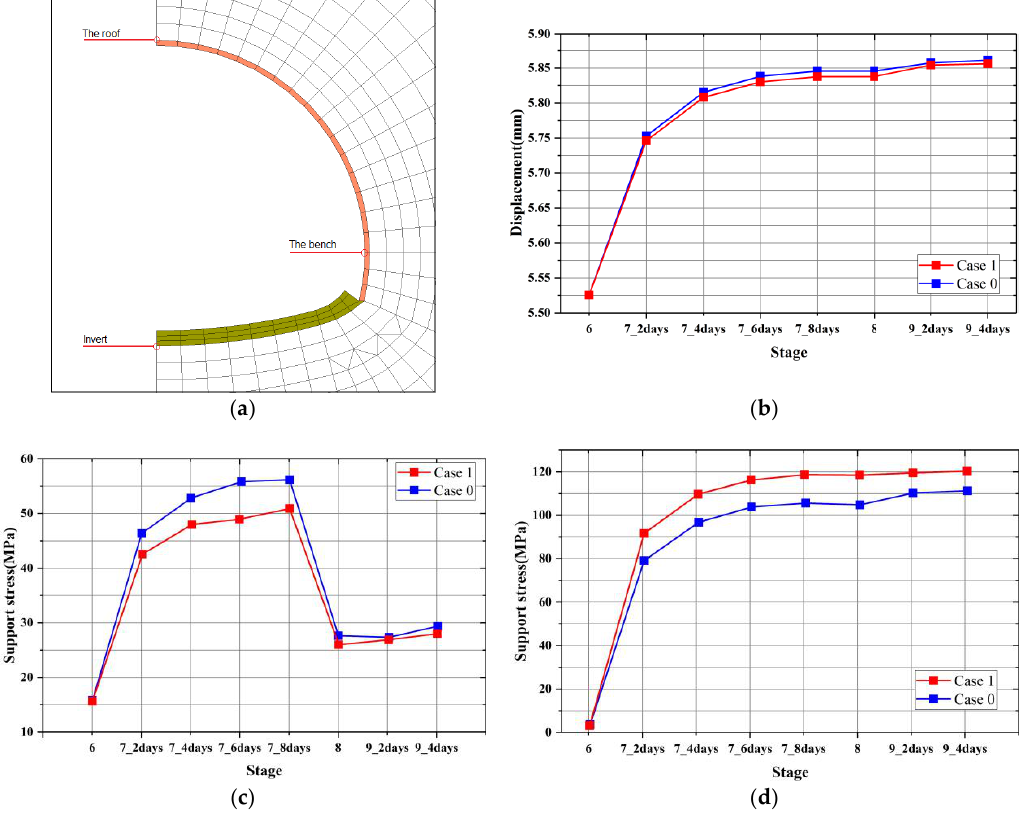
Figure 13. The minor principal stress of the roof. ( a ) Monitoring points plot; ( b ) the displacement of the roof; ( c ) the support stress of the bench; ( d ) the support stress of the invert. As a primary support of tunnel surface, concrete lining serves a number of functions, such as supporting adjacent ground and resisting ground erosion and degradation. The minor principal stress of the reinforced concrete lining in the roof part and the foot part are presented in Figure 14b,c, respectively. The minor principal stress is reduced in the lining structure after the improving part installation. The pore pressure in the permeable shotcrete layer is maintained at zero around the liners before the lining is applied. The pore pressure in the impermeable lining structure attempts to reach linear hydrostatic